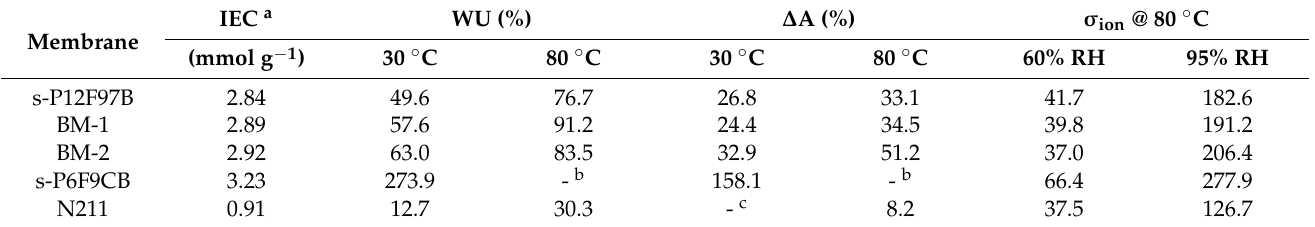
Table 2. IEC, water uptake, water swollen, and proton conductivity of the BM-X membranes. IEC Membrane